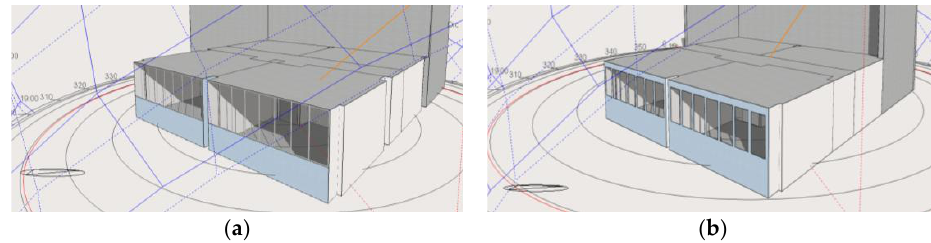
Figure 6. gbXML model geometries in the DesignBuilder V.6 display interface. ( a ) as-is STD model; and ( b ) as-is T-BIM model.